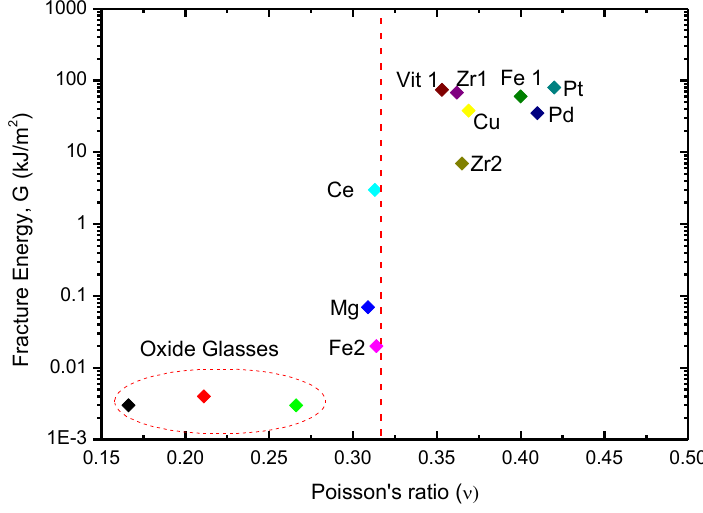
Figure 4. A plot of fracture energy versus Poisson’s ratio for a range of bulk metallic glasses and oxide glasses. Data are taken from Lewandowski et al. [69]. There seems to be an apparent tough-to-brittle transition at a critical Poisson’s ratio of 0.32, marked by the red dotted line. The symbols represent the following BMGs— Pt : Pt